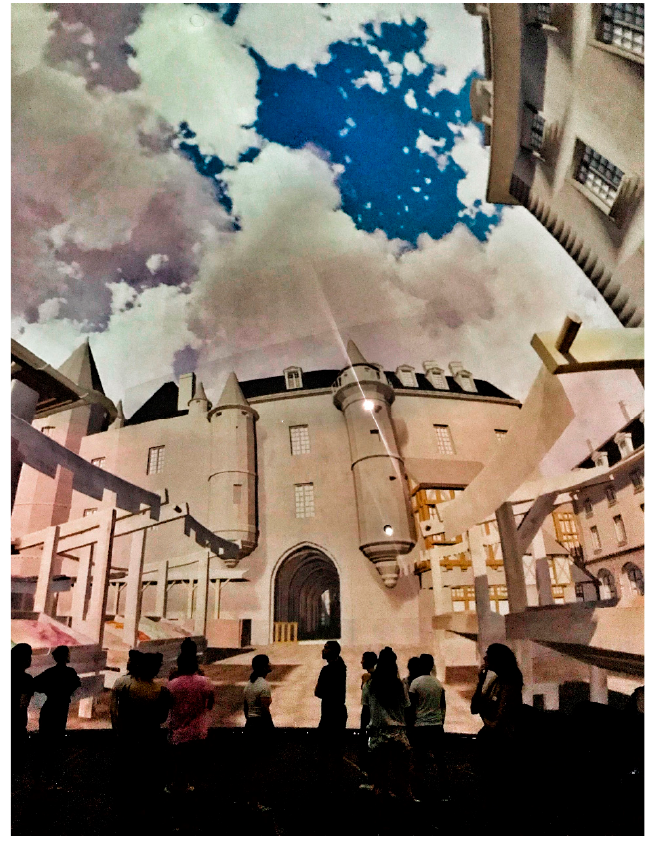
Figure 2. The immersive projection in the collective setting with 12 participants (Coll_Exp).